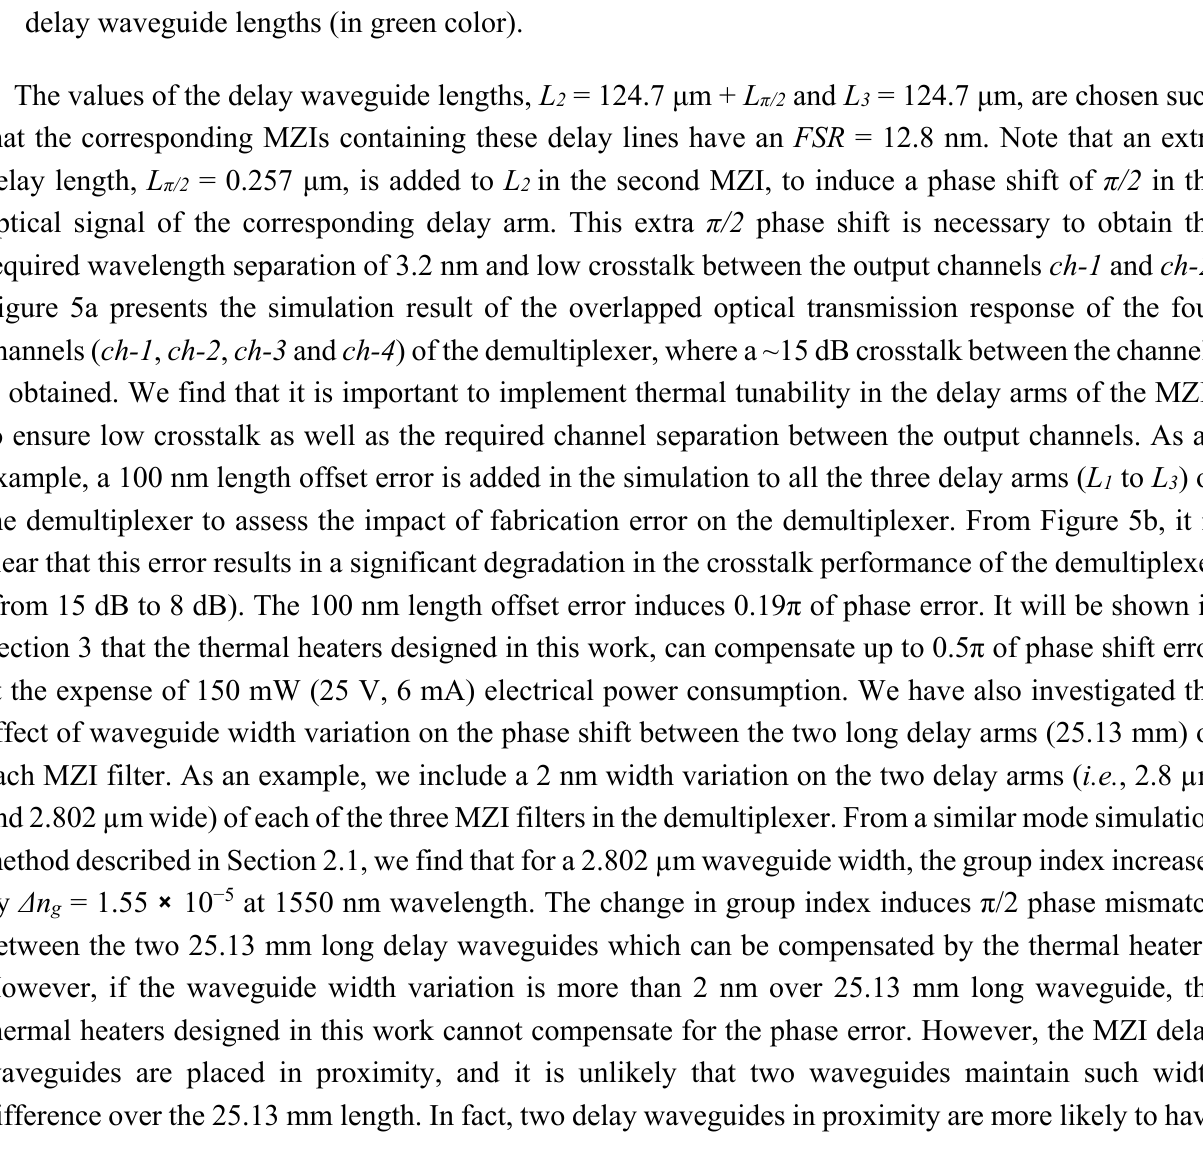
Figure 4. Schematic of the 1 × 4 channel wavelength demultiplexer architecture with the integrated Cr heater on the delay arms of the Mach-Zehnder interferometer (MZI) (not to scale). V 1 to V 6 : electrical pad to apply the DC voltages for thermal tuning, G: ground pad, L 1 to L 3 : delay waveguide lengths (in green